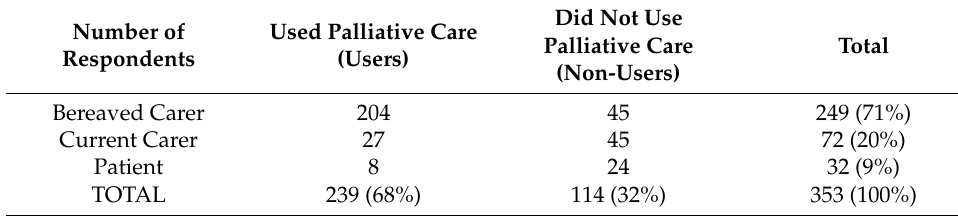
Table 1. Distribution of survey respondents.